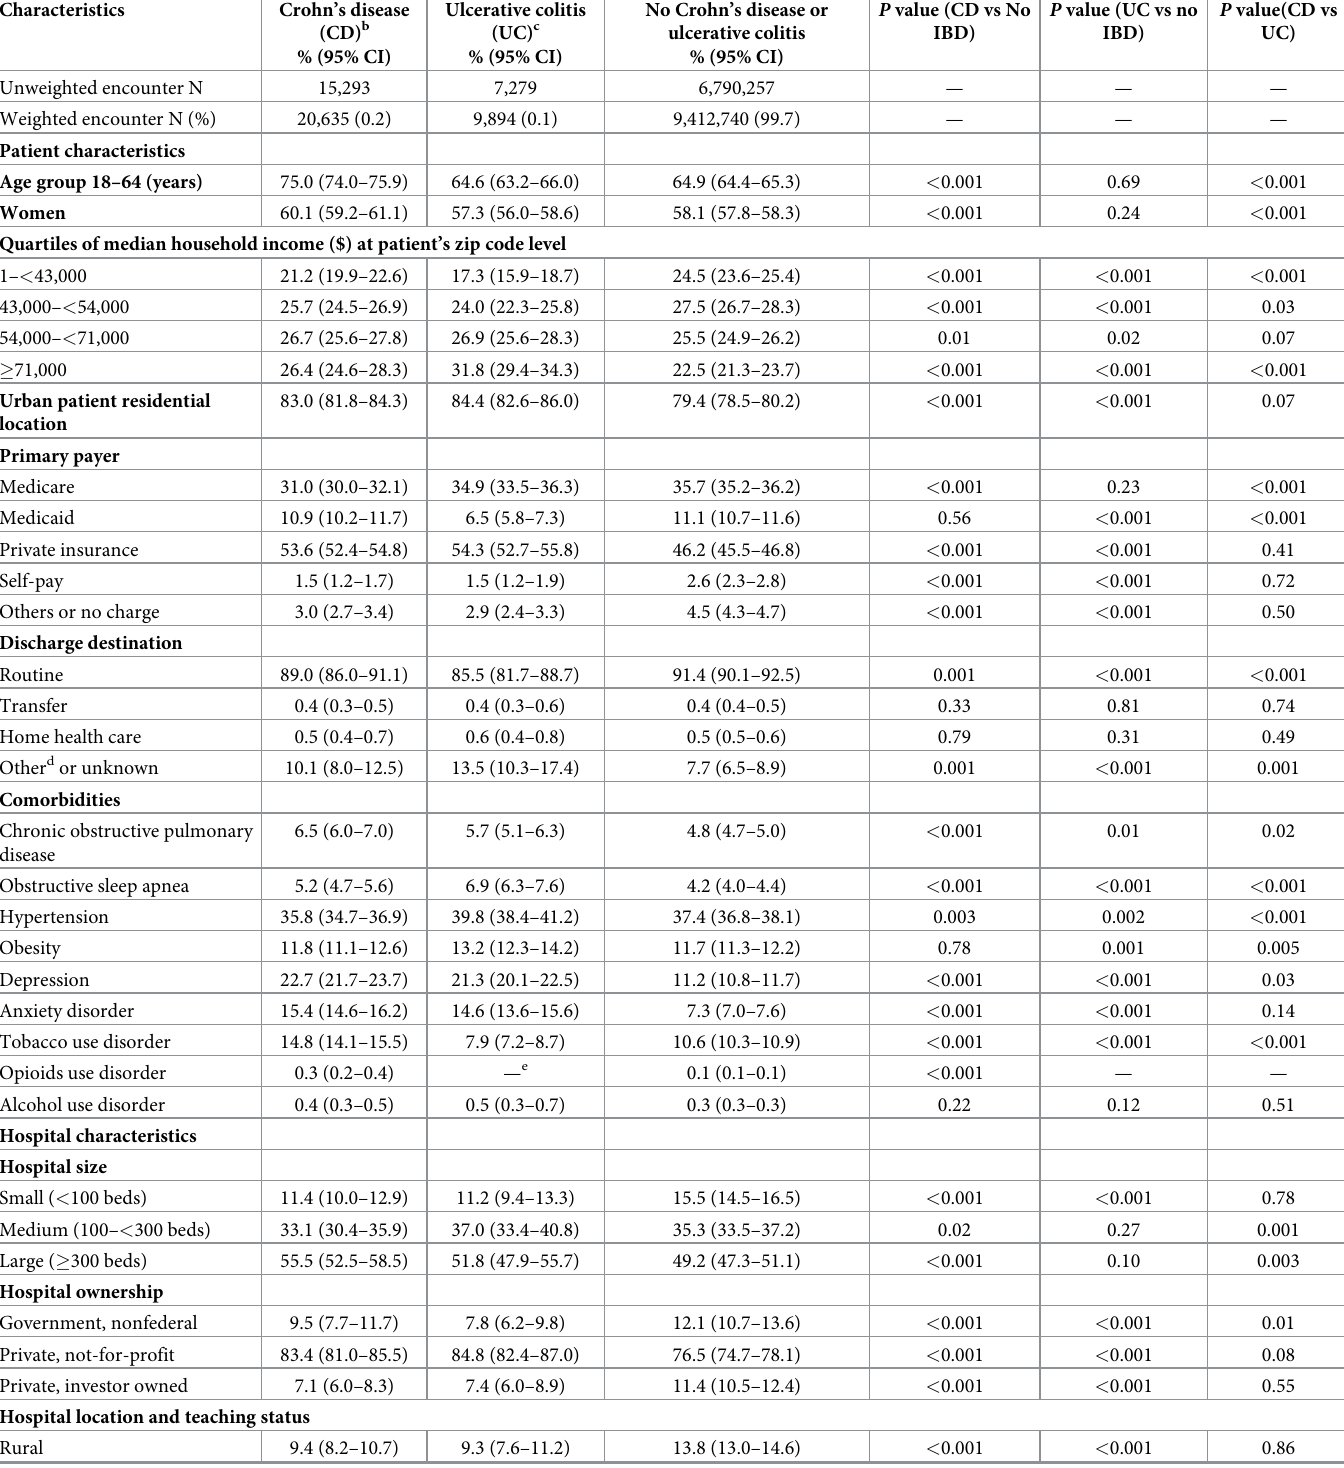
Table 1. Distributions of patient demographic and hospital characteristics associated with major in-scope a ambulatory surgery encounters by inflammatory bowel disease status, 2017.